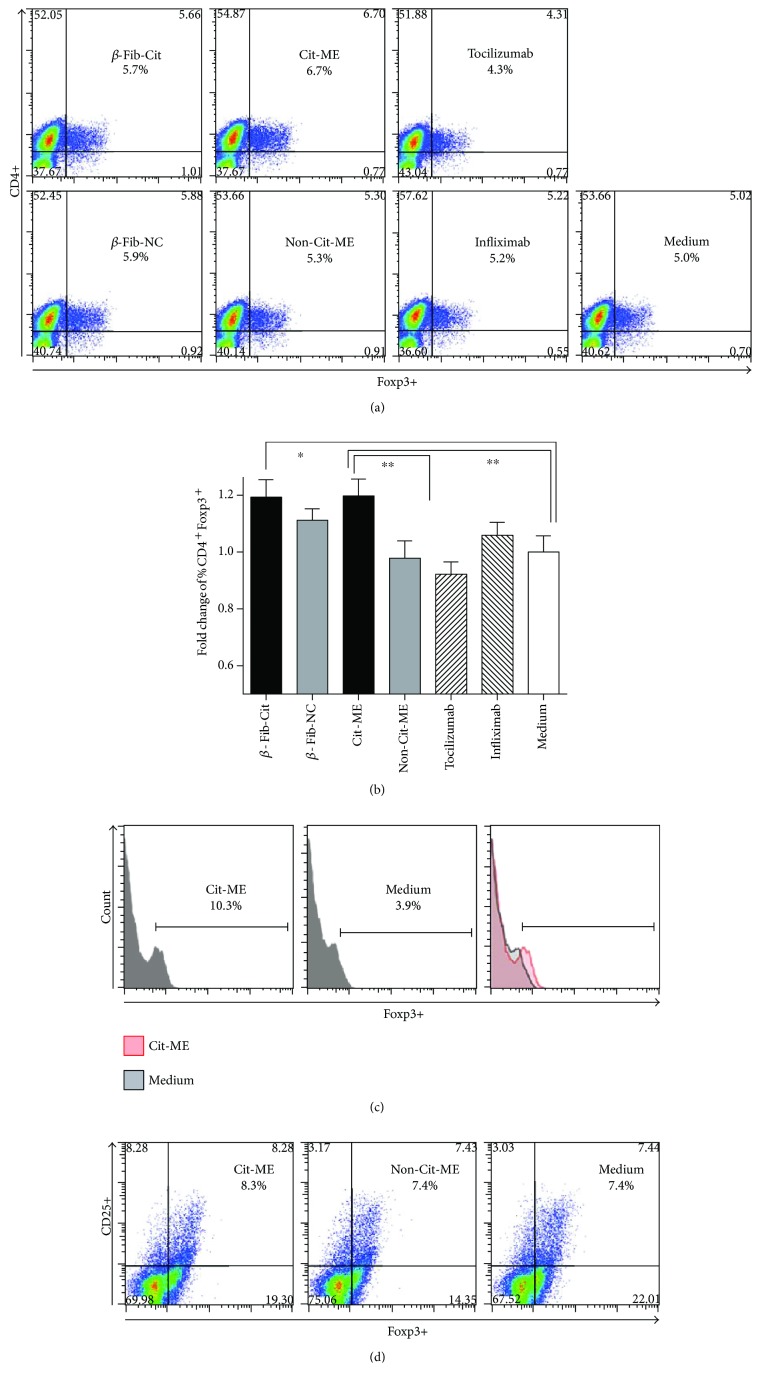
Cit-ME upregulates Treg in vitro. (a) Representative dot plot of CD4+Foxp3+ T cells from a RA patient. Positive staining is presented in the right upper quadrant of each graph with the percentage indicated. (b) The fold change of % CD4+Foxp3+ T cells determined by flow cytometry (n = 6–13). Data are presented as mean values (∗p = 0.04, ∗∗p = 0.02). (c) Histogram shows representative Foxp3 staining for one RA patient, gated for CD4+ T cells. (d) Representative dot plot of RA patient PBMC gated for CD4 and analyzed for CD25 and Foxp3 expression.